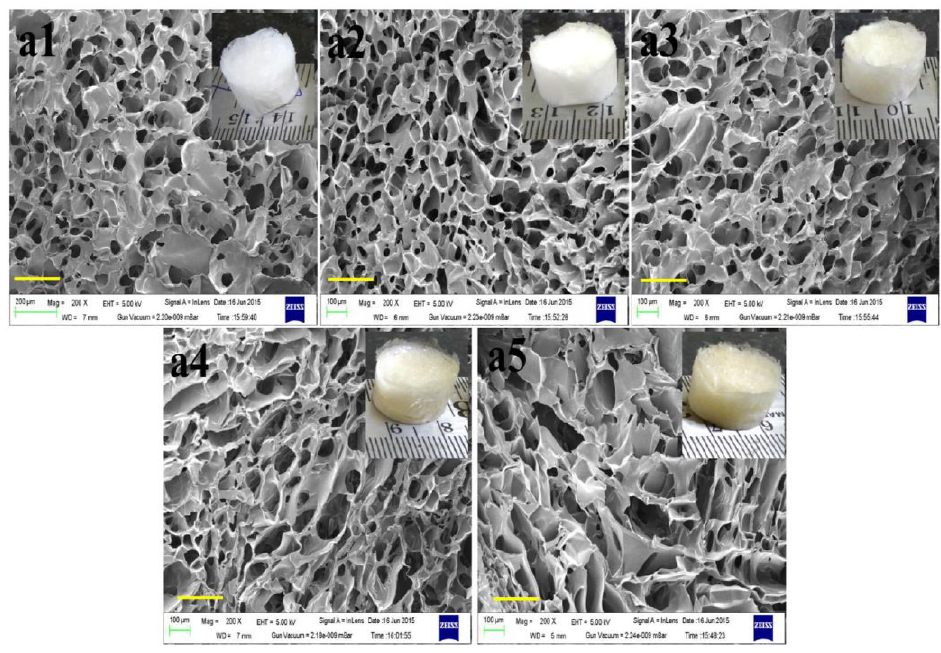
Figure 4. Microphotographs by SEM showing surface morphology of crosslinked silk fibroin (SF) and honey silk fibroin scaffolds (a1) SF, (a2) HSF1 with 1% honey concentration, (a3) HSF2 with 2% honey concentration, (a4) HSF4 with 4% honey concentration, and (a5) HSF6 with 6% honey concentration. Reproduced from Materialia, 12 (2020), 100703; Rajput et al.; Honey-loaded silk fibroin 3D porous scaffold facilitates homeostatic full-thickness wound healing (reproduced with permission from [171], Elsevier, 2020).